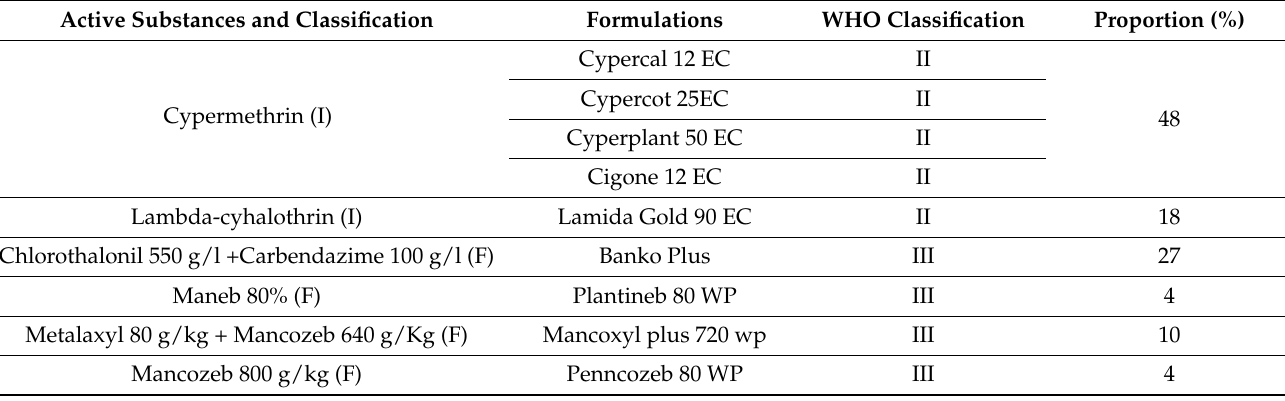
Table 4. Types of pesticides used in the lowland farms in Yaound é Table 4 Types of pesticides used in the lowland farms in Yaoundé.